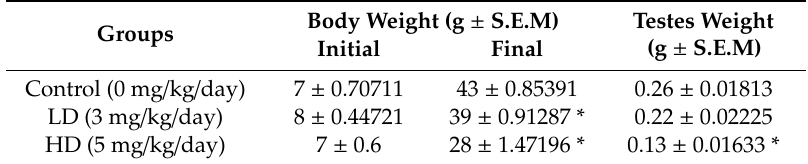
Table 3. Comparative study of body and testes weight of the male pups after the completion of 28 days of TCS-treated / TCS-untreated.